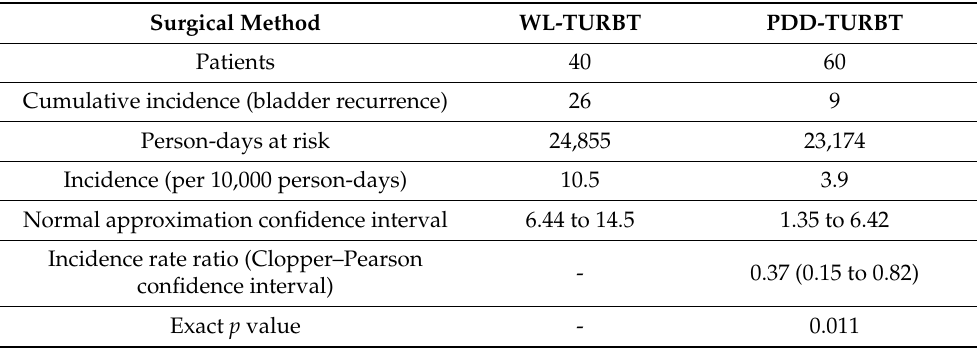
Figure 4. Swimmer’s plot of the 100 patients with time on follow-up. Individual swimmer’s plots for each patient showing the number of follow-up days for the WL-TURBT group (upper figure) and the PDD-TURBT group (lower figure). Follow-ups were performed by routine white-light cystoscopy and conventional urine cytology. Green and blue square boxes indicate low-grade and high-grade non-muscle-invasive bladder cancer (NMIBC), respectively. The red circle indicates a recurrent tumor of muscle-invasive bladder cancer (MIBC). The number of patients who experienced repeated recurrence, ranging from one to four, is shown in each figure. Table 3. A cumulative incidence analysis of bladder recurrence by person-time